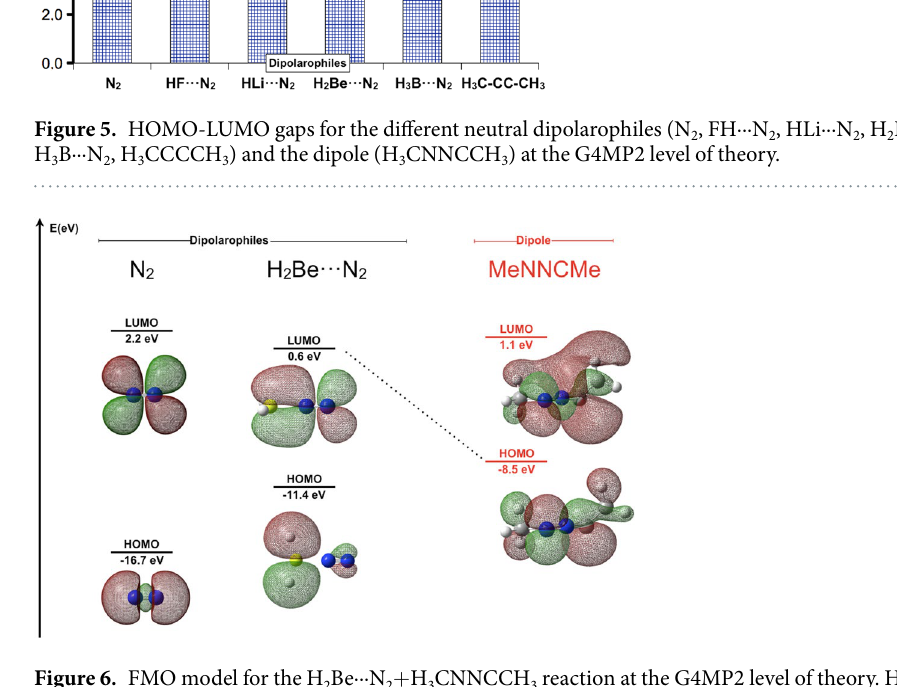
Figure 6. FMO model for the H 2 Be···N 2 + H 3 CNNCCH 3 reaction at the G4MP2 level of theory. HOMO-LUMO levels for the N 2 molecule are shown for the sake of